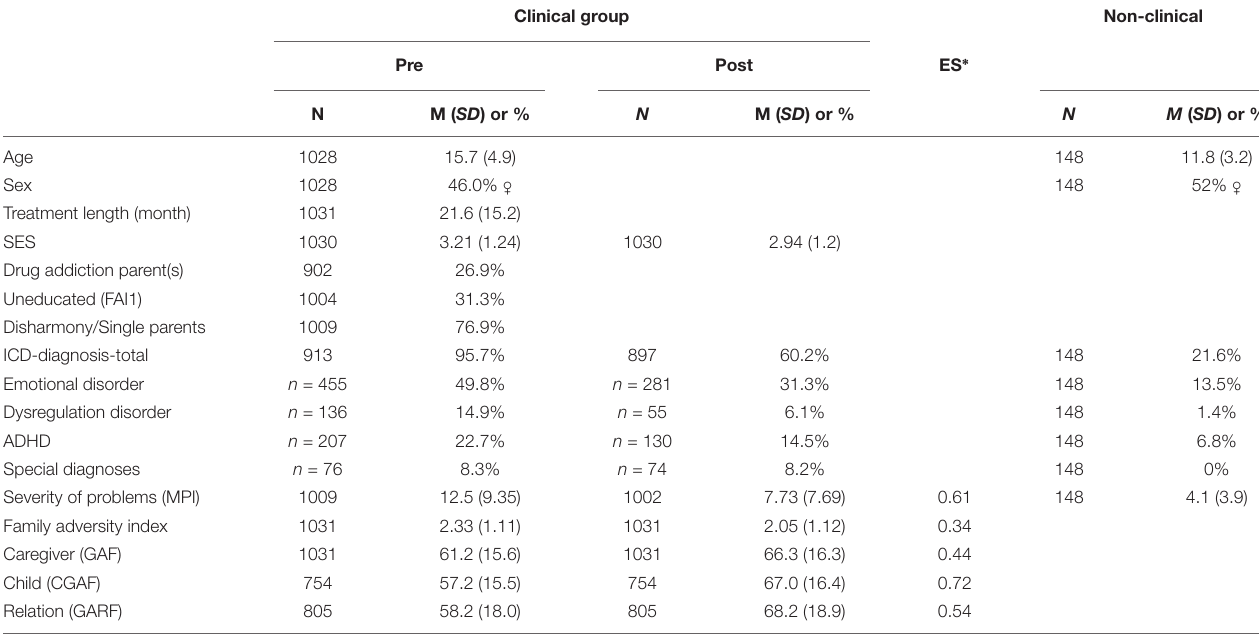
TABLE 1 | Demographics, diagnostics, and pre-/post-symptom